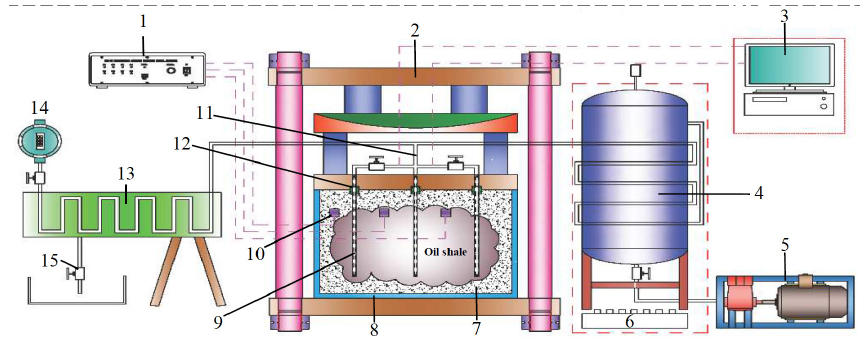
Fig. 4. Test system for pyrolysis of oil shale and extraction of oil and gas under- ground [38]: 1 – an acoustic emission system, 2 – a press machine with a capacity of 1000 tons, 3 – an automatic temperature and pressure control system, 4 – a heater, 5 – a water pump, 6 – a gas heater, 7 – concrete, 8 – the main chamber, 9 – wells, 10 – sample cracking detection systems, 11 – steam injection pipelines, 12 – seals, 13 – liquid cooling and separation systems, 14 – flow meter, 15 – liquid products